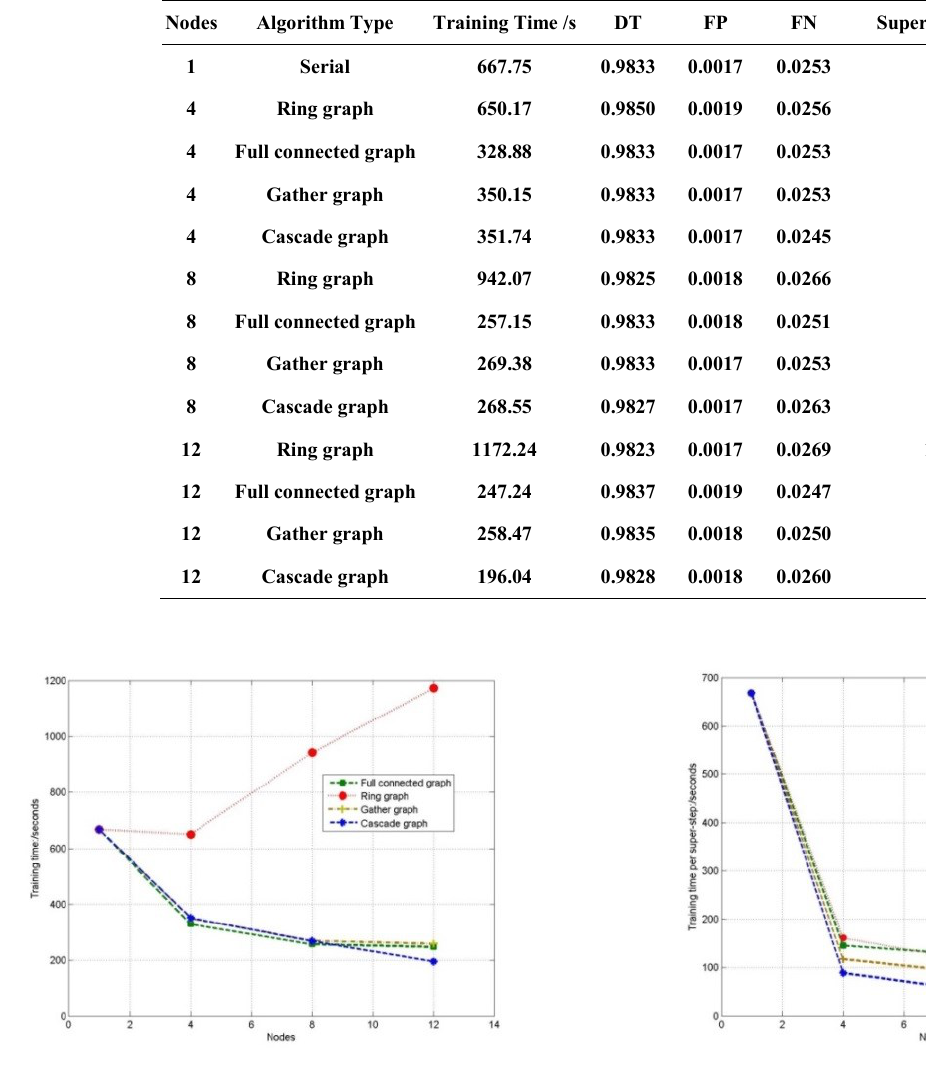
Fig. 10. Training time per super-step of 4 algorithms. Fig. 9. Training time of 4